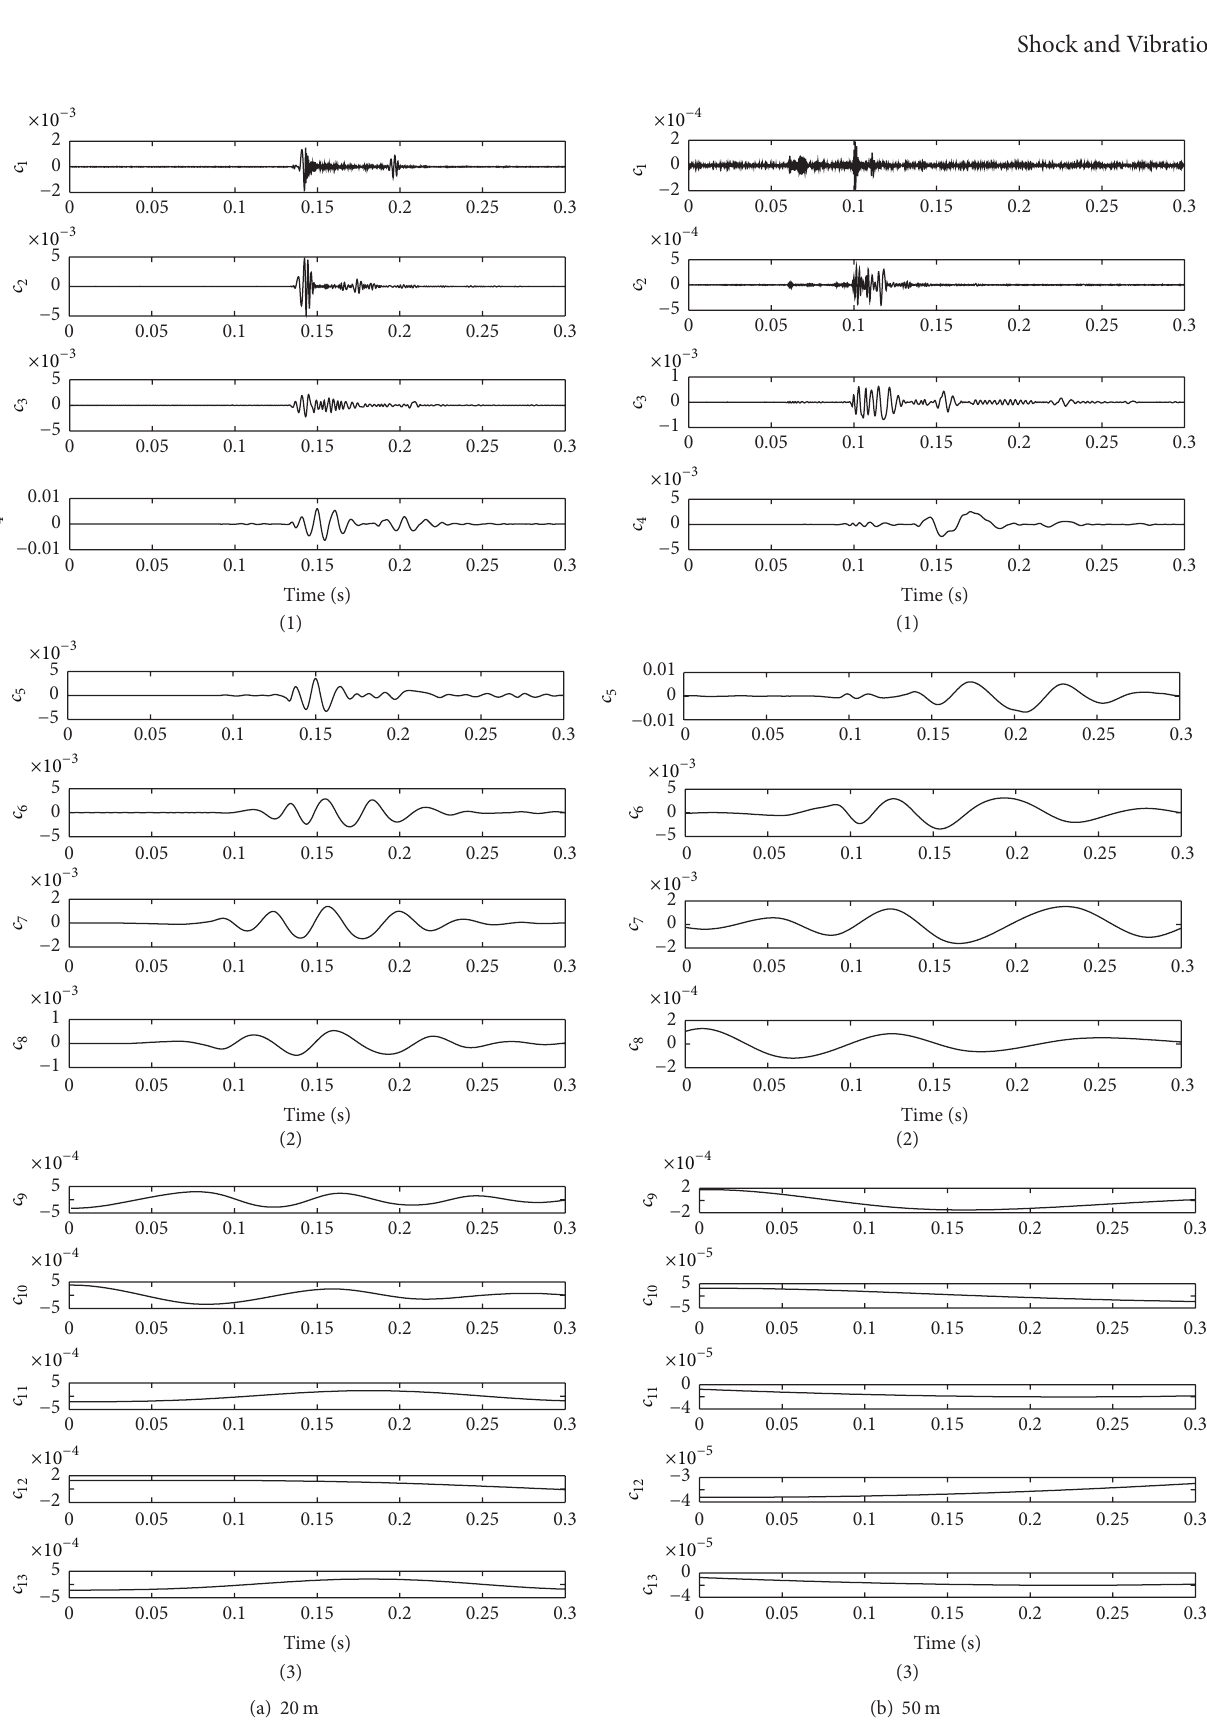
Figure 13: EMD decomposing results of blasting vibration signals at different measuring